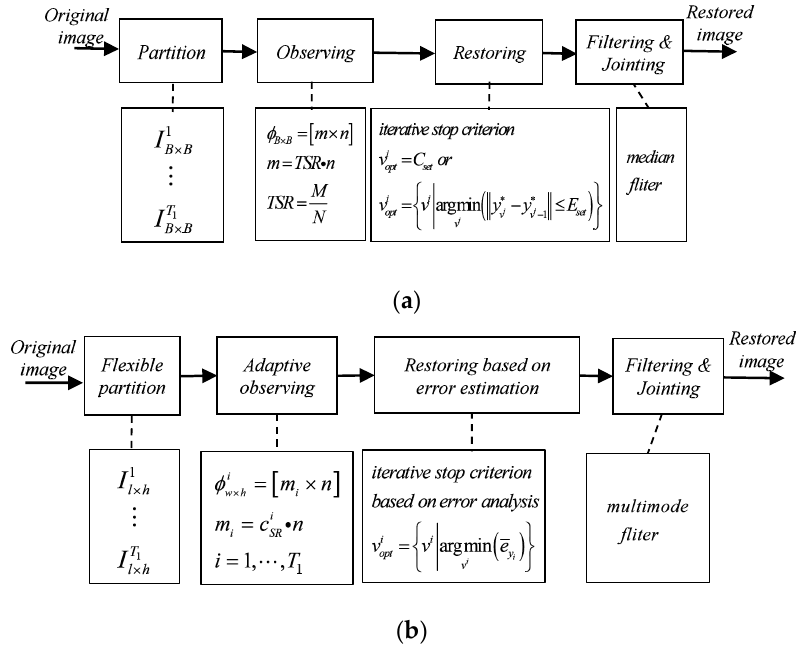
Figure 2. The workflow of two block-compressive sensing (BCS) algorithms. ( a ) Typical BCS algorithm, ( b ) FE-ABCS algorithm.